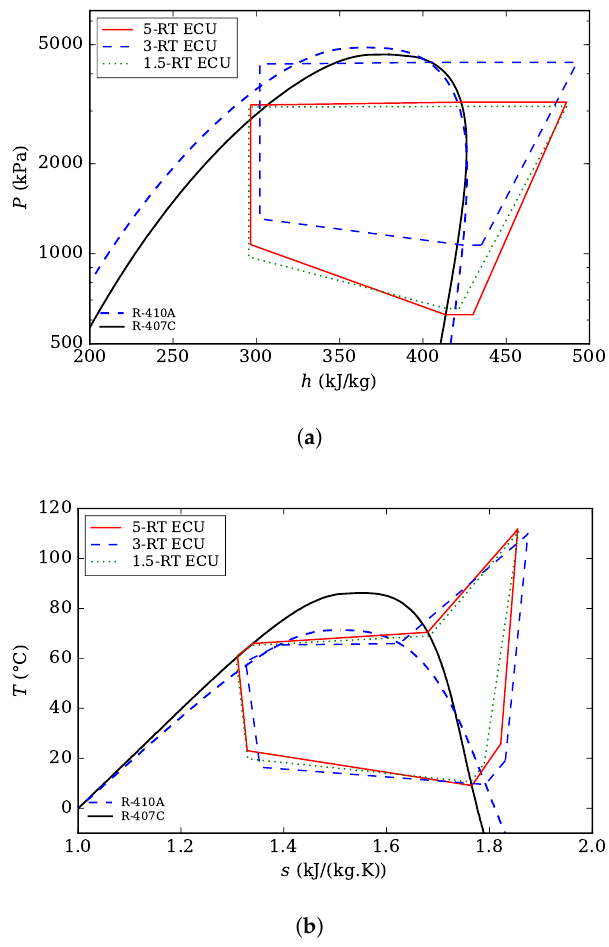
Figure 8. ( a ) P - h and ( b ) T - s diagrams to compare 1.5-RT, 3-RT, and 5-RT ECUs at Test Condition 1. Table 4. First- and second-law analysis results for 1.5-RT, 3-RT, and 5-RT ECUs at Test Condition 1.